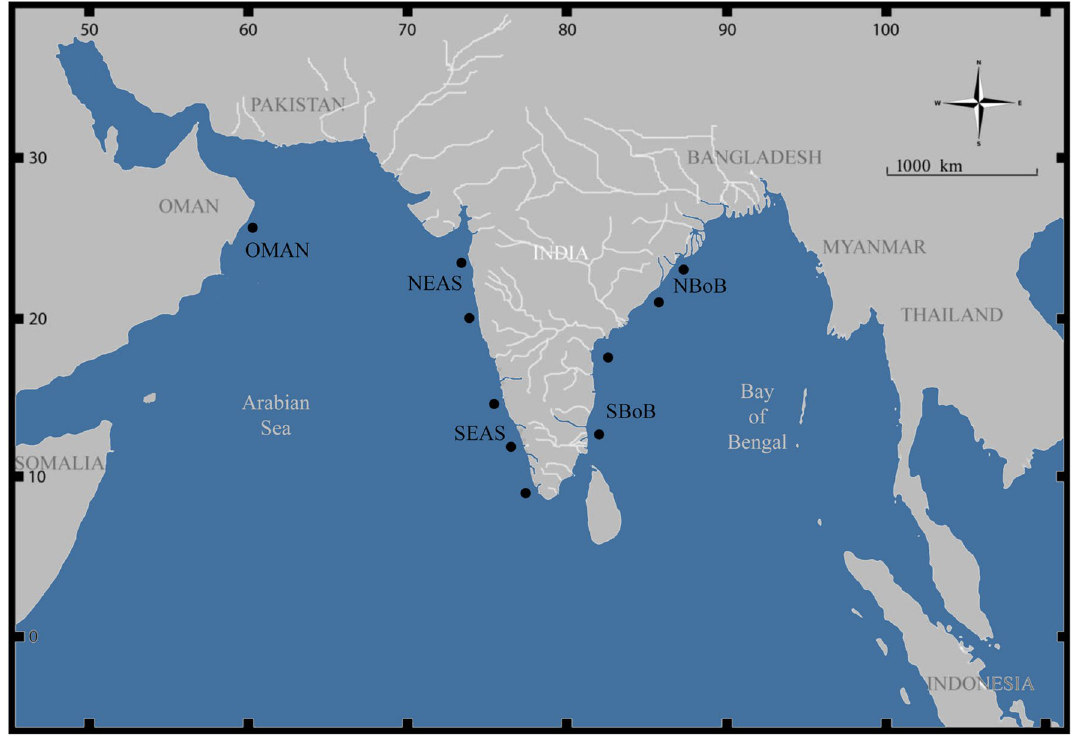
Figure 6. Ecoregions or sampling sites of Sardinella longiceps . OMAN Oman Sea, NEAS North East Arabian Sea, SEAS South East Arabian Sea, SBoB South West Bay of Bengal, NBoB Northwest Bay of Bengal. Black